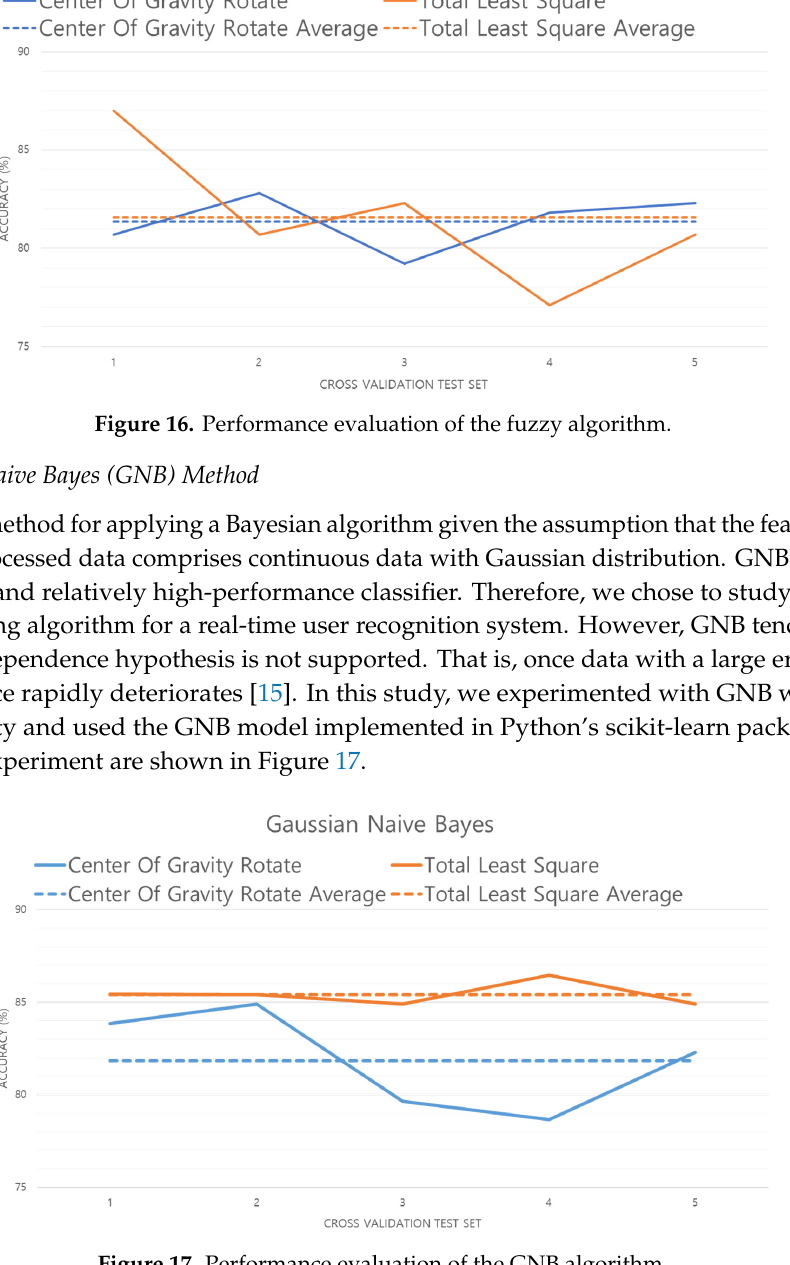
Figure 17. Performance evaluation of the GNB algorithm.